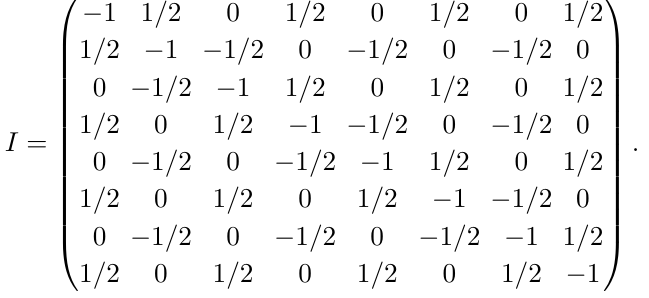
Figure 10 . The outer-automorphism acting on A 2 diagram of su (3) leads to A 1 diagram of su